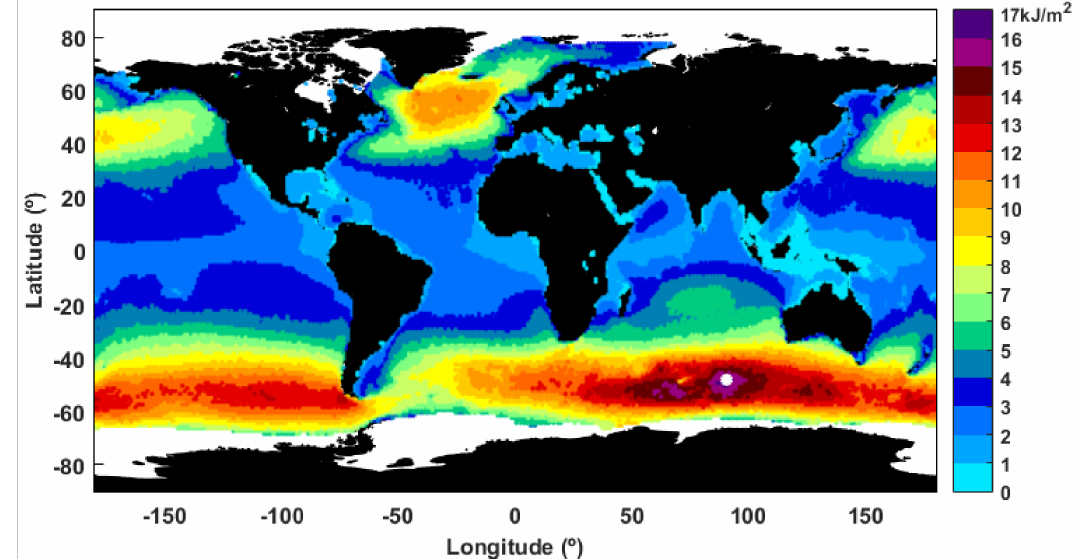
Figure 6. Mean wave energy density ( E w-CCI ) over the 27-year time interval (1992–2018) based on data from CCI-SS (Climate Change Initiative for Sea